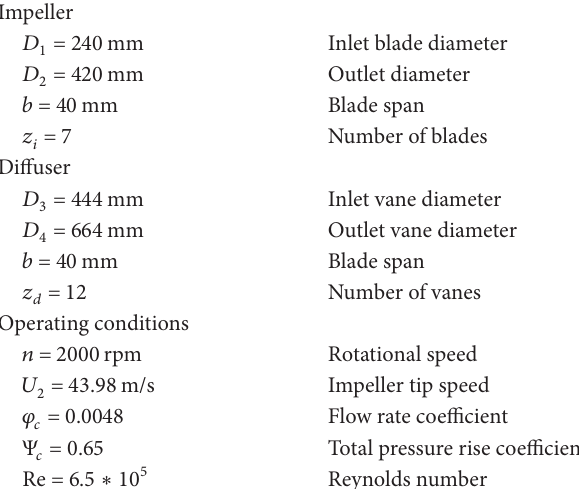
Table 1: Geometric data and operating